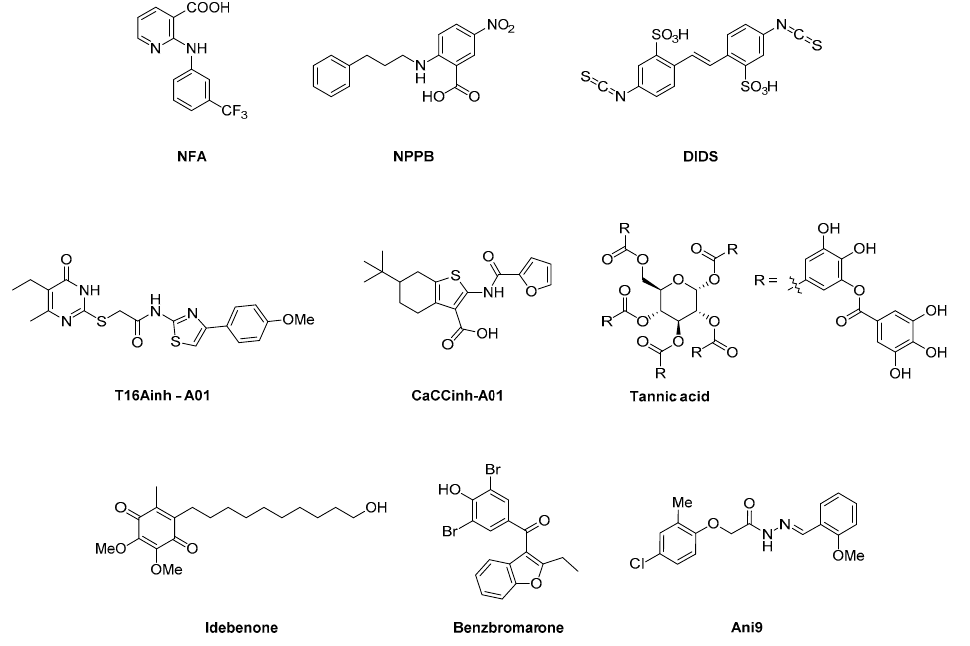
Figure 1. Structures of representative ANO1 channel blockers.